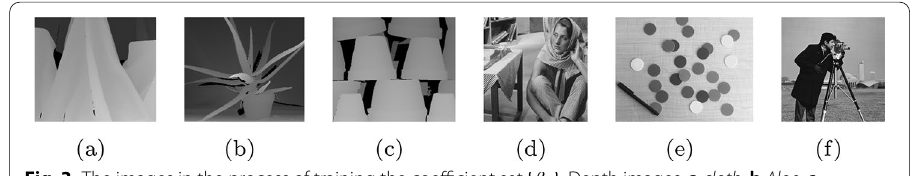
Fig. 3 The images in the process of training the coefficient set { β k } . Depth images: a cloth , b Aloe , c flowerpot ; natural images: d barbara , e chips , f man